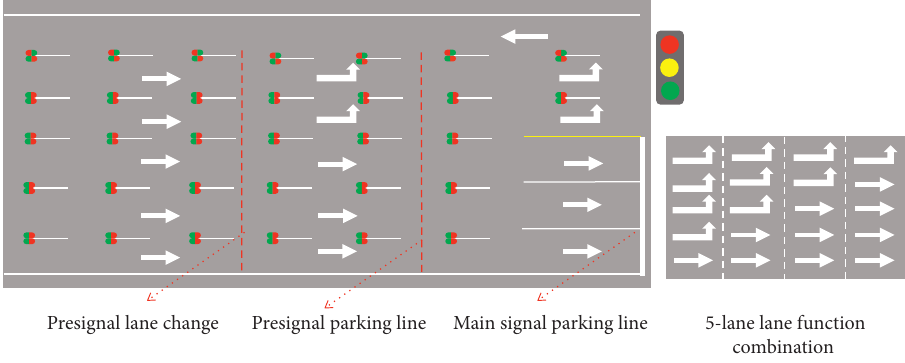
Figure 6: Illustration of the five-entrance-lane